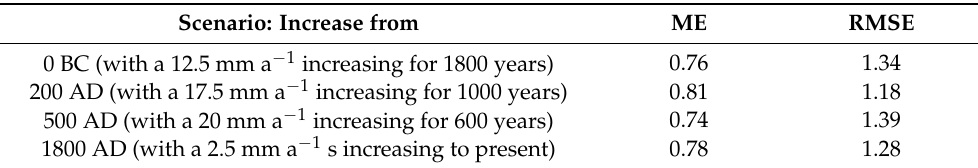
Figure 11. Model efficiency for several scenarios as a function of the ( A ) start of first sedimentation rate (SR) increase, ( B ) start of second SR increase and ( C ) height of the SR both for Chencha and Dembelle floodplain. Table 3. Model efficiency for a selection of the best performing scenarios of sedimentation increase based on radiocarbon ages of the Chencha